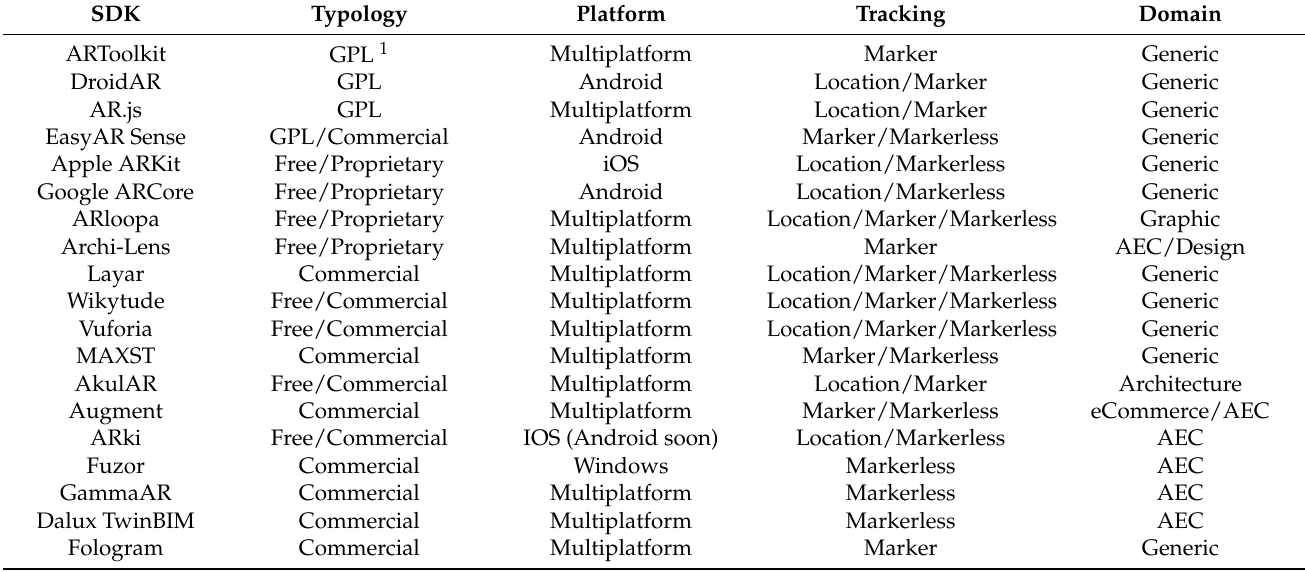
Table 2. List of SDKs and relative characteristics.